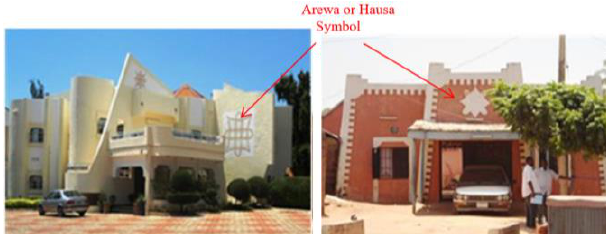
Figure 11. Pictorial Views of Postmodern Residential Designs Displaying Northern Cultural Symbol Popularly Known as Arewa Symbol ( Aliyu,